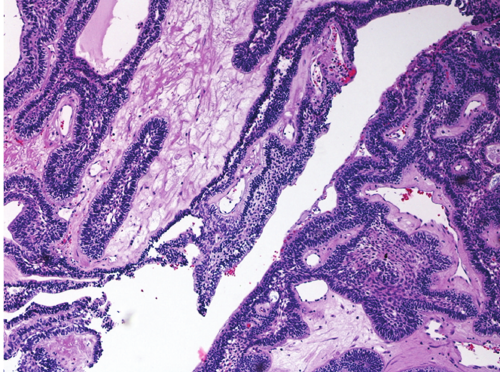
Figure 4: In some areas, stroma was collagenized.